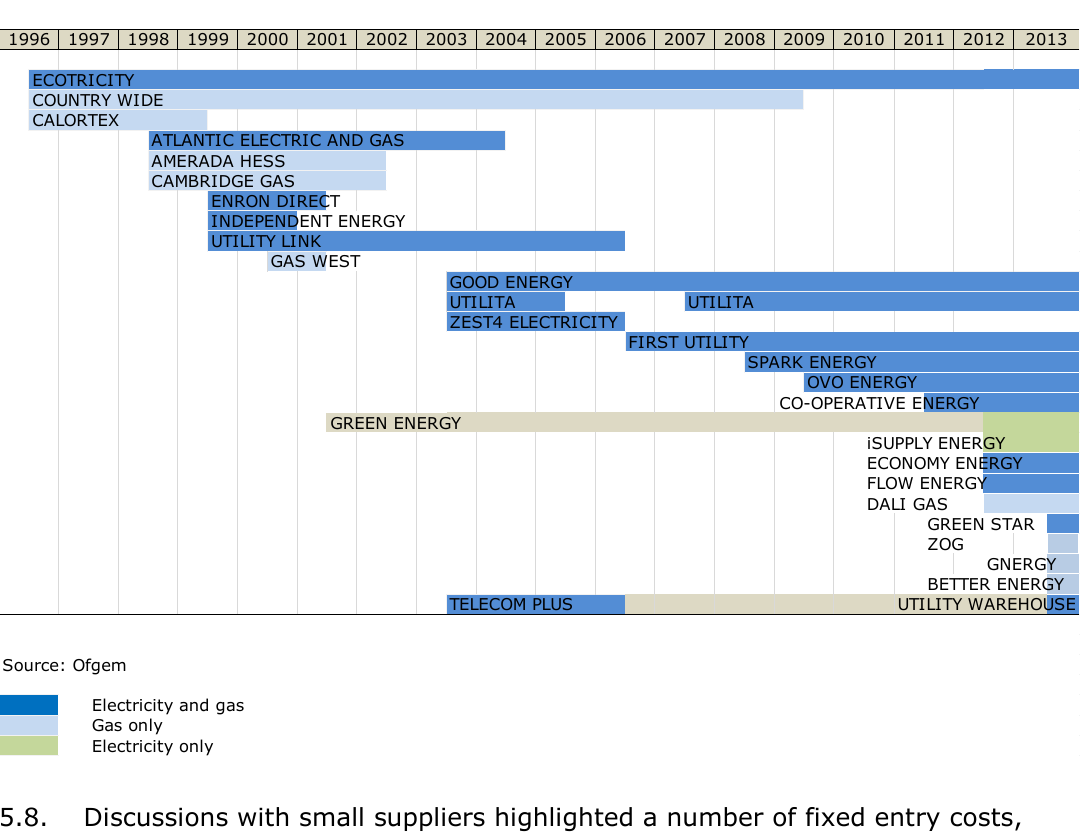
Figure 38 - Non-incumbent entry and exit to the GB domestic gas and electricity